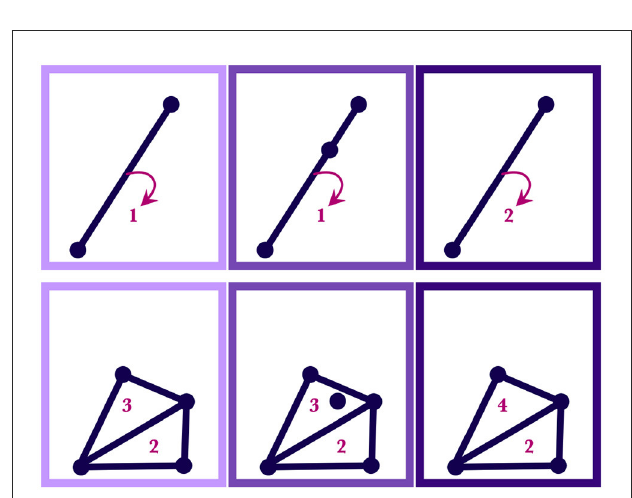
FIGURE5 Both the upper and lower diagrams show how regions of a silhouette are reweighted as motor traces are absorbed by the wordform. In a given row, the leftmost panel shows the initial weighted region, SIL C , n ( t ); the middle panel shows the point, M ( t ), that will be added; the rightmost panel shows the resulting region, SIL C , n + 1 ( t ), with new weights. The numbers indicate the weights of the simplices. The upper diagram shows a simplicial 1-complex and the lower diagram shows a simplicial 2-complex.